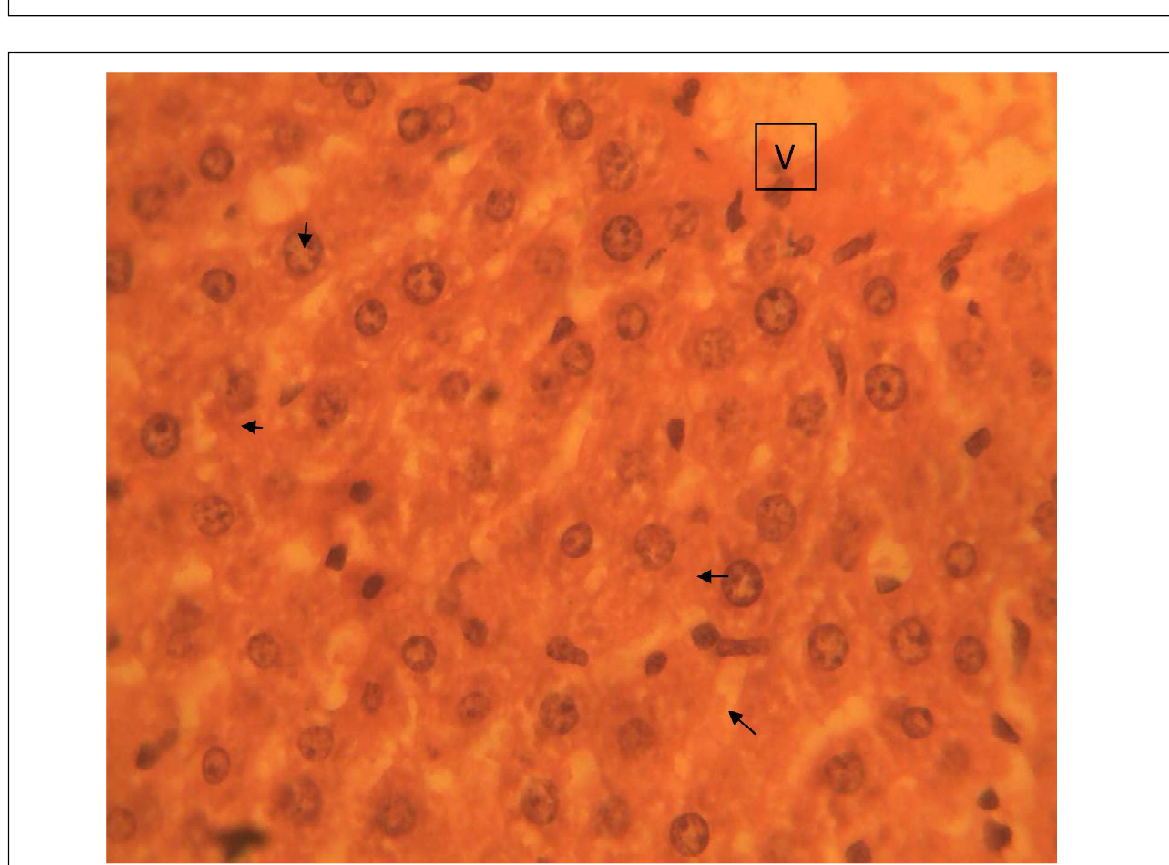
Plate 4: Male liver of the group exposed to 200 mg/kg of methanol